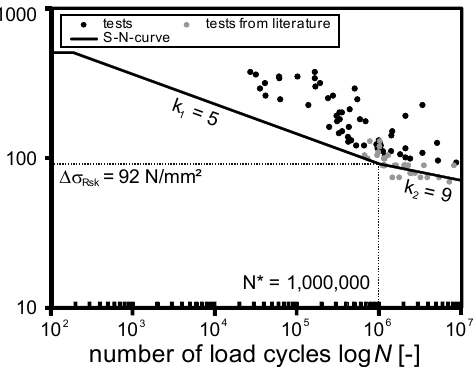
Figure 10. Assessed S–N curve for lattice girders in the latest technical approvals